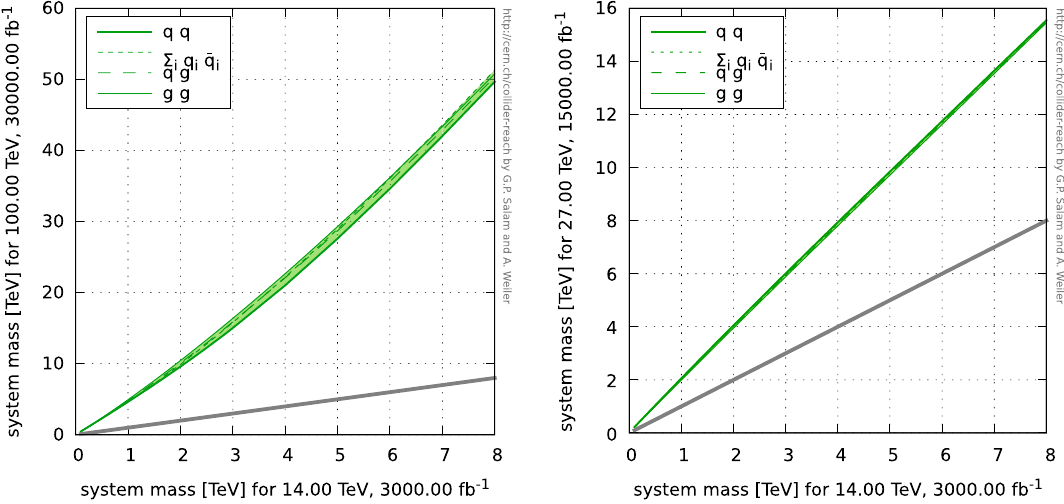
Fig. 15.5 Left (right): the discovery/exclusion mass reach for resonance searches at FCC-hh (HE-LHC), as a function of the equivalent target for the HL-LHC